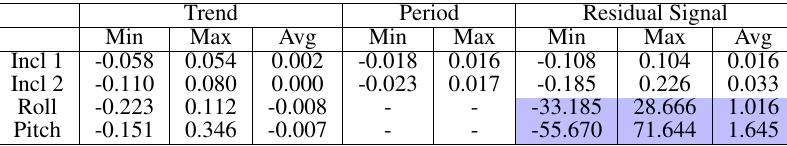
Table 3. Trend, period and residual signal of the respective inclination signals. Incl 1 and Incl 2 refer to the external inclination sensors. All values in mm/m. The highest values are marked in blue.